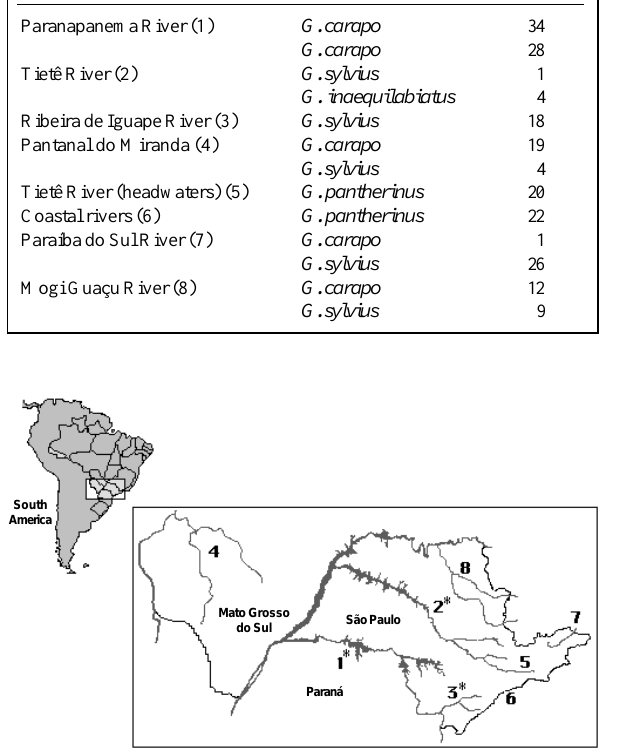
Figure 1 - Geographic localities of Gymnotus collection sites. 1, Parana- panema River (sample size: 34); 2, Tietê River (33); 3, Ribeira de Iguape River (18); 4, Pantanal do Miranda (23); 5, Tietê River (headwater) (20); 6, Coastal rivers (22); 7, Paraíba do Sul River (27); 8, Mogi Guaçu River (21). *, Sample previously studied by morphological analysis.